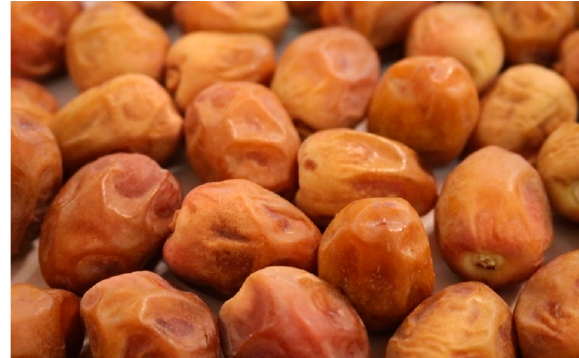
Figure 27. Sample of Al-Rashudia dates.